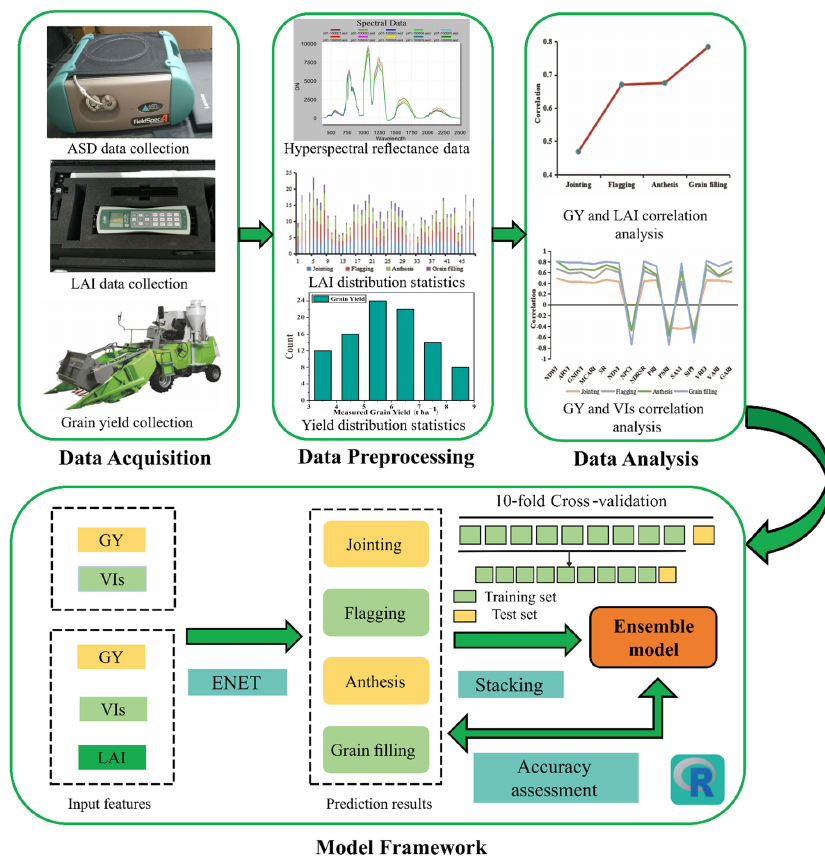
Figure 2. Technology